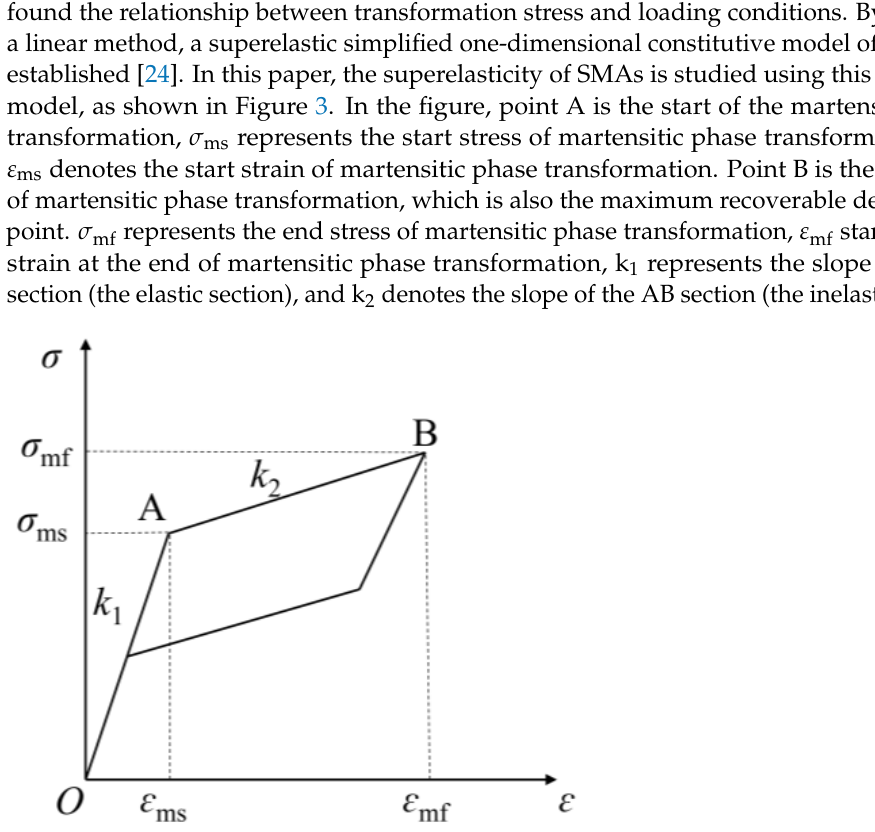
Figure 3. Simplified hyperelastic stress–strain relationship of SMAs. According to Figure 3, the modulus of elasticity E 1 in the elastic phase (OA) and the modulus of elasticity E 2 in the inelastic phase (AB) of SMA materials are